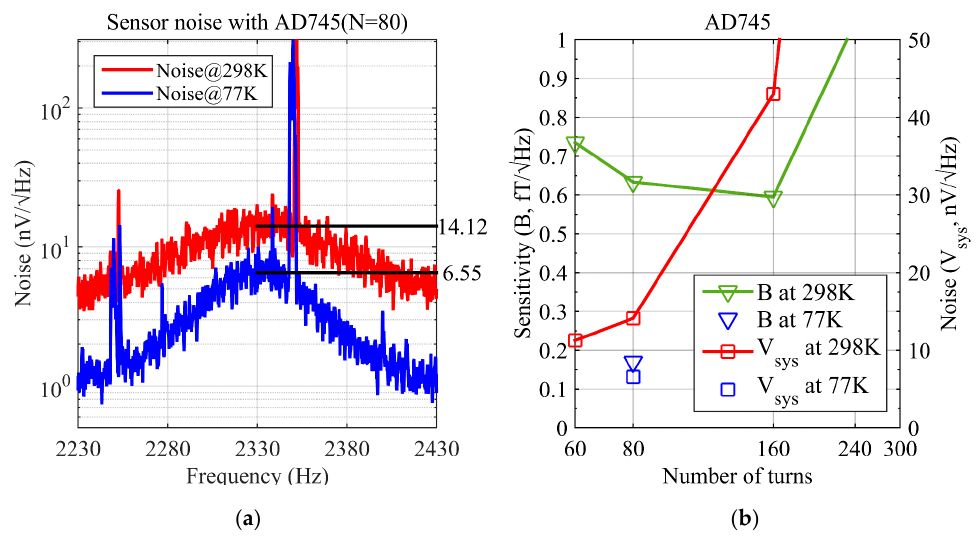
Figure 5. System noise and field sensitivity of the coil sensor at 298 K and 77 K. ( a ) noise of the coil sensor with AD745 (the number of turns is 80, center frequency is 2330 Hz, the noise is 14.12 nV/ Hz at 298 K and 6.55 nV/ Hz at 77 K, both measured in the EMSR, there are two interferences of harmonic, 2250 Hz and 2350 Hz, respectively); ( b ) field sensitivity of the coil sensor with AD745 (green curve: field sensitivity in fT/ Hz at 298 K, left Y axis; red curve: noise in nV/ Hz at 298 K, right Y axis, blue triangle: field sensitivity at 77 K, blue square: noise at 77 K). To summarize, the design of CCS is based on a dense square solenoid structure with an 80-turn single layer rigid coil and an AD745 preamplifier.